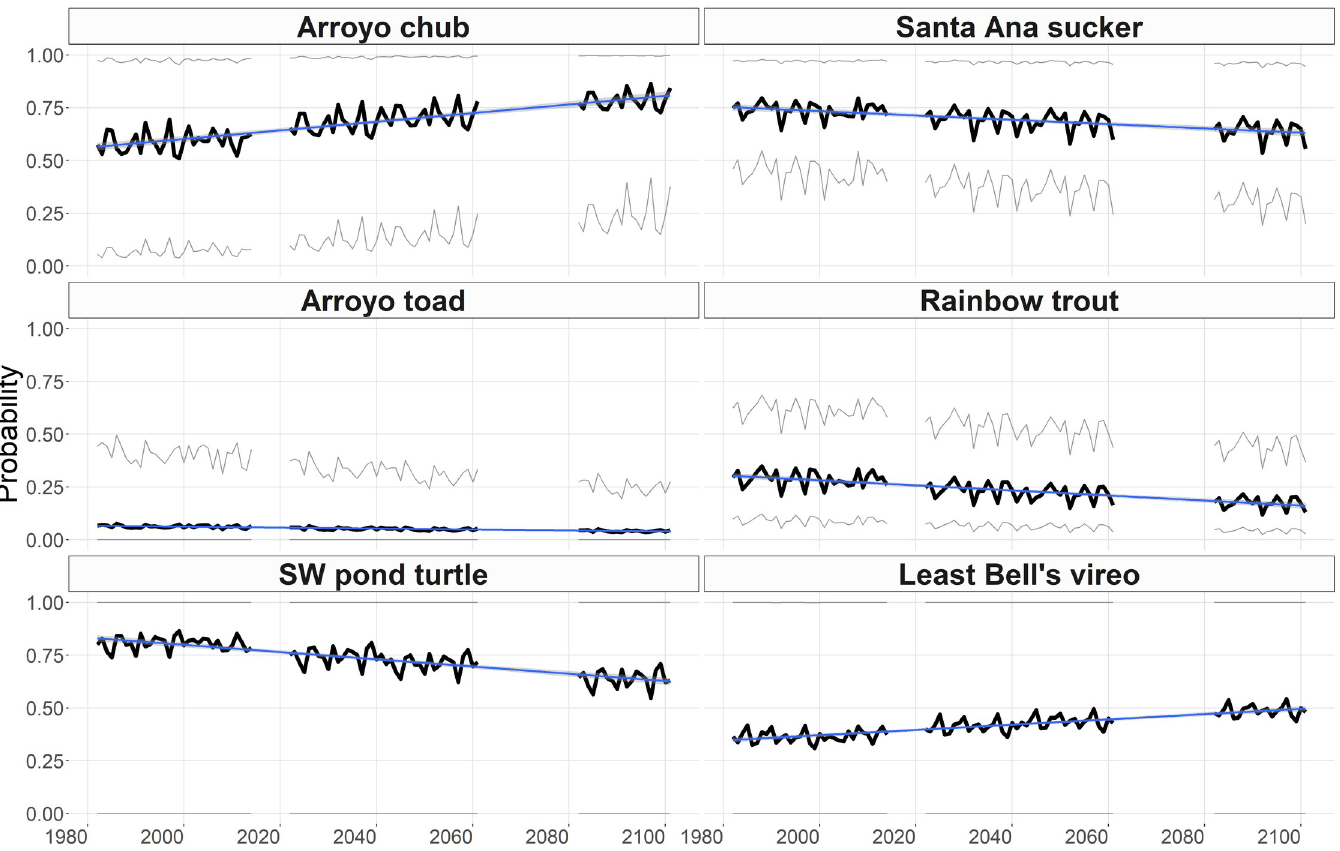
Fig 2. Annual predicted probability of occurrence from the baseline years to the end-of-century due to stream temperature changes for each species. The dark black line shows the mean probability of occurrence annually across all the stream reaches. The upper and lower light grey lines show the 95 th and 5 th percentile probabilities for the stream reaches. Breaks in line show the years that were missing from our analysis. The trend line is a linear model of the mean annual probability of occurrence.